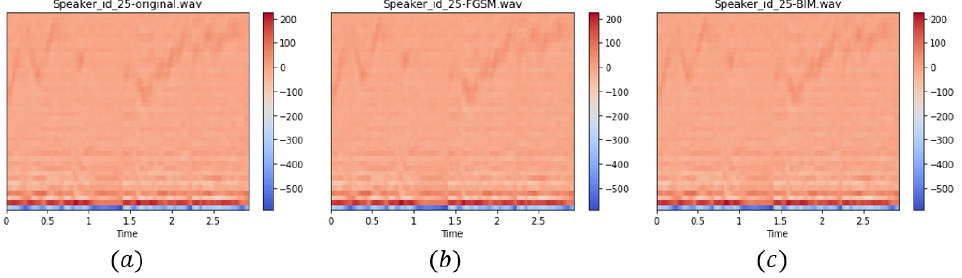
Figure 9. A example of the MFCC of audios with by FGSM- and BIM-based frequency-domain perturbations. Figure ( a ) shows the MFCC of the original audio, while figure ( b , c ) show the MFCC of the adversarial audio generated by the FGSM and BIM algorithms